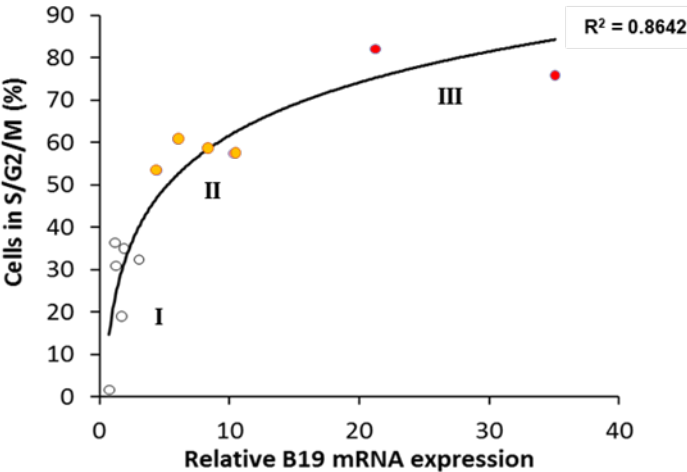
Figure 6. Comparison of relative levels of B19 mRNA (as in Figure 5A) and cell cycle status (as in Figure 5B). Each dot corresponds to the mean result for a single cell line or clone ( n = 3), classified to groups I (white marks ○ ), II (orange marks ● ) and III (red marks ● ). Logarithmic regression analysis and R 2 values are presented.